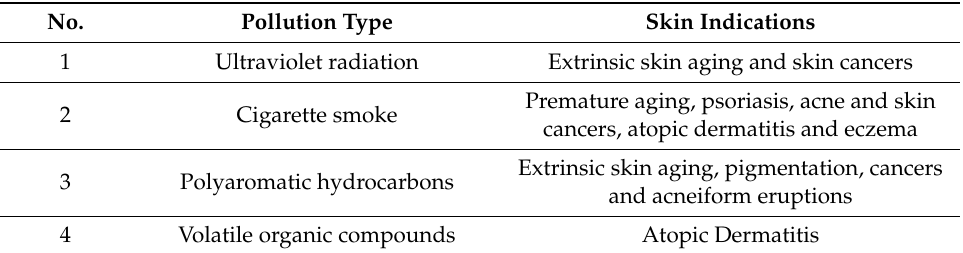
Table 2. Pollution and skin